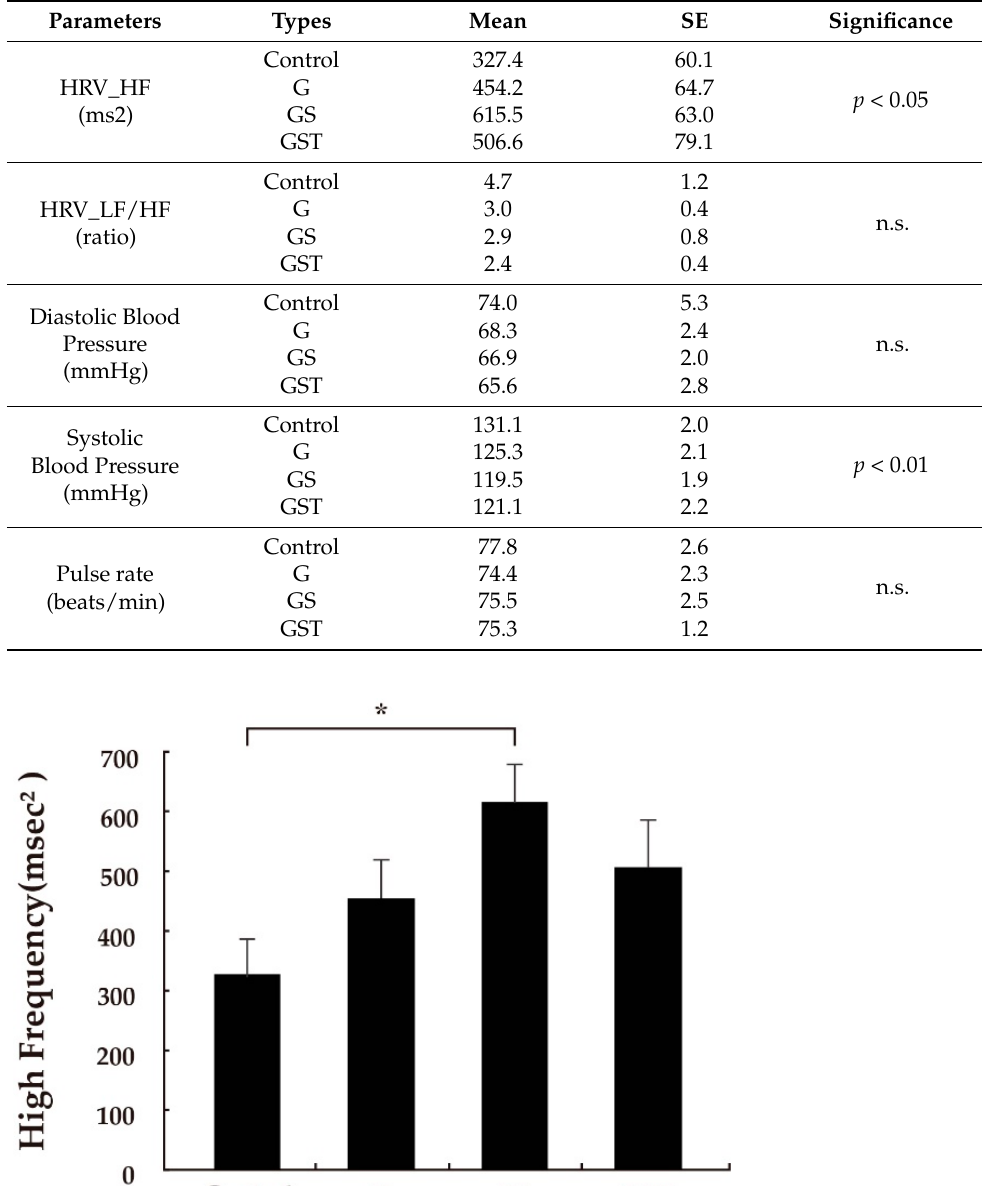
Table 2. Physiological values produced by the four rooftop images. Control: no vegetation with concrete floor; type G: grass vegetation; type GS: grass-shrubs vegetation; type GST: grass-shrubs- trees vegetation; n = 15, significance verified by ANOVA.